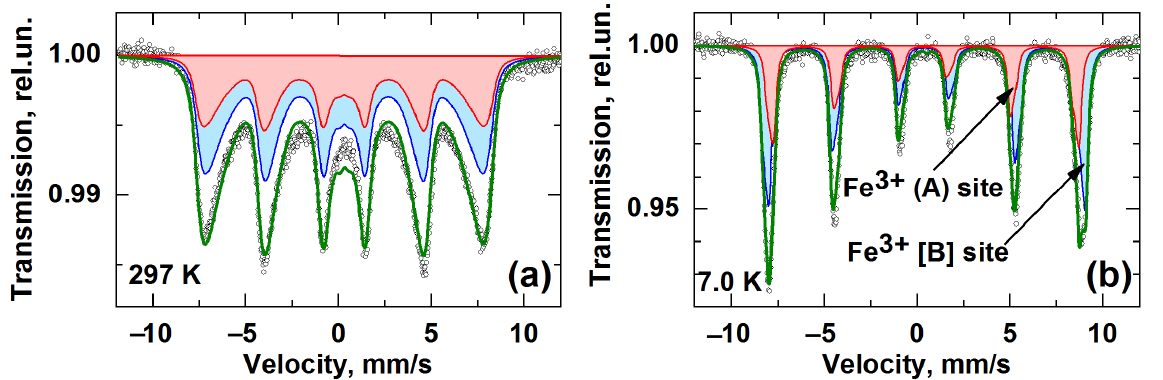
Figure 3. Mössbauer spectra of iron oxide nanoparticles at 297 K ( a ) and 7.0 K ( b ). Points are experimental values; solid lines are calculated spectra.